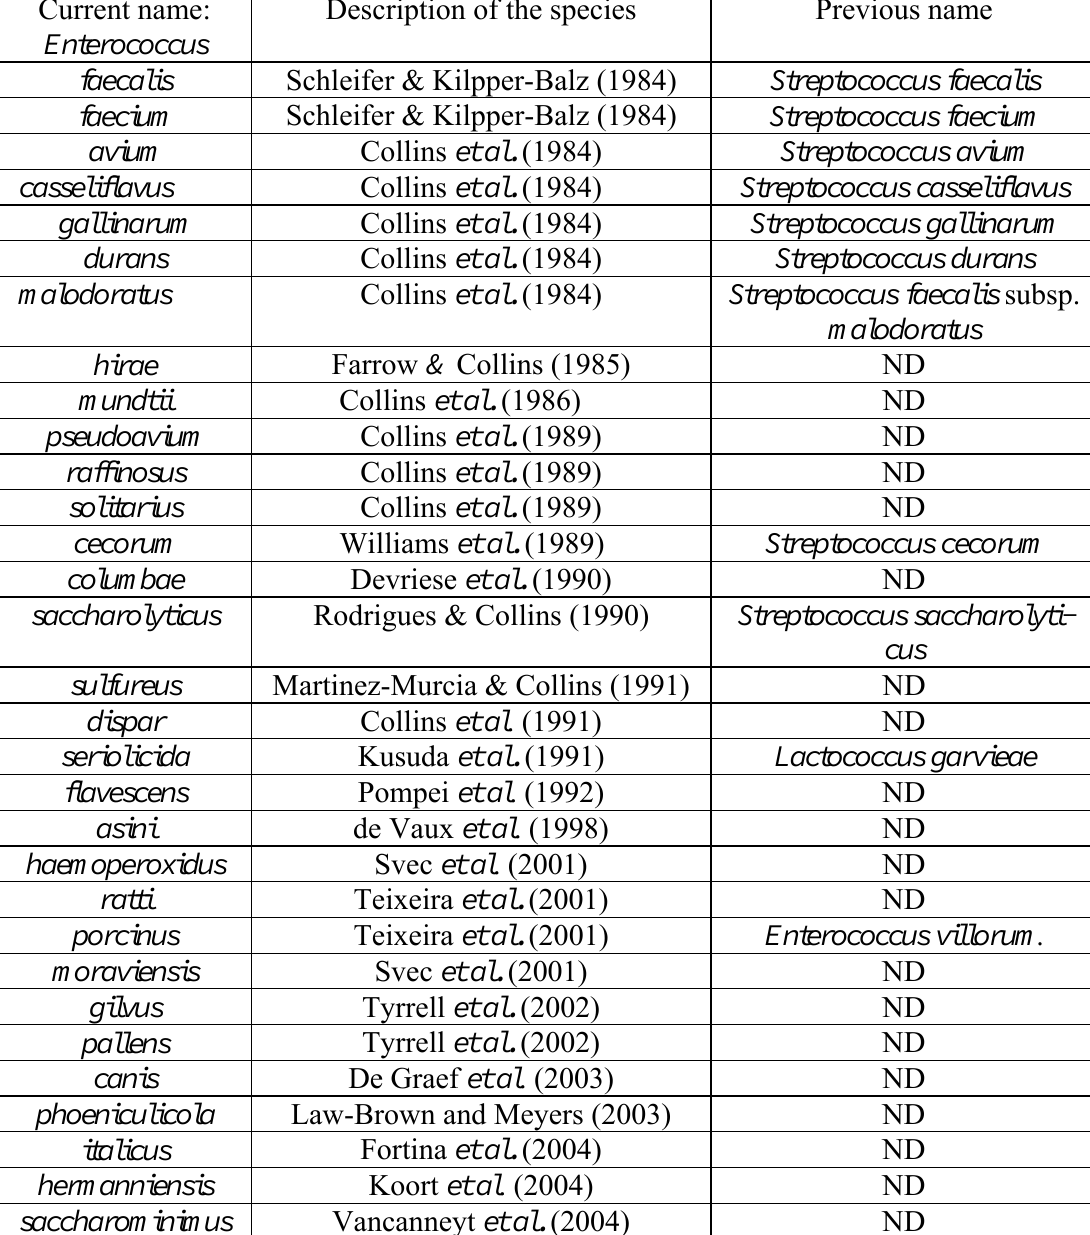
Table 1. List of Enterococcus species